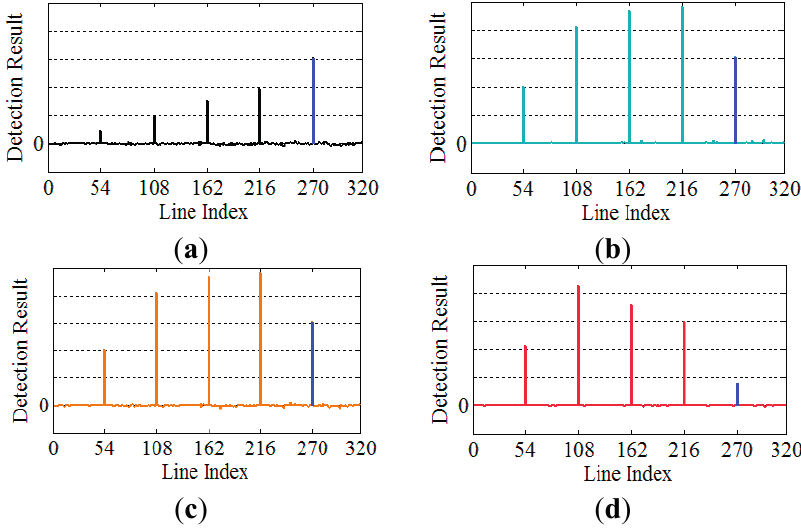
Figure 12. Detection results transect plots of line 54. ( a ) CEM, ( b ) ACE, ( c ) ASMF with n = 1, ( d ) ASMF with n =